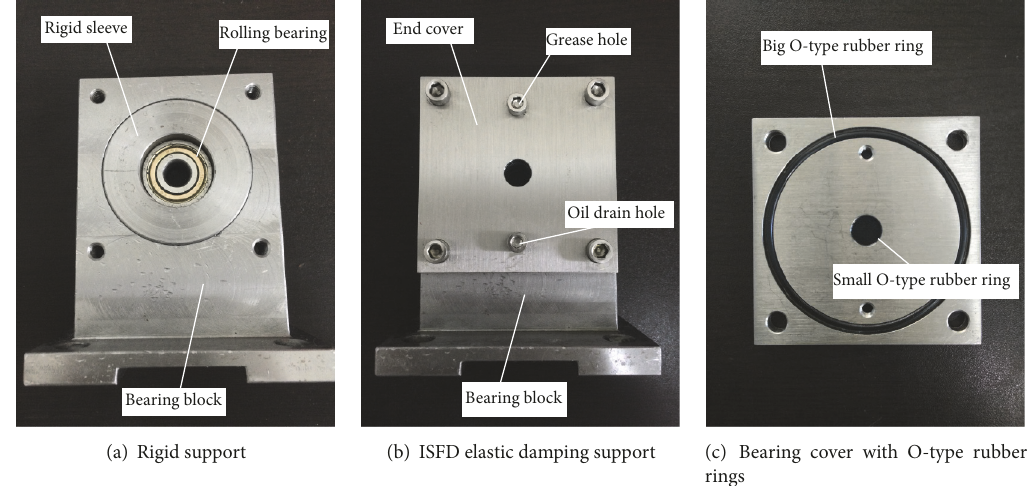
Figure 6: Two kinds of experimental support and bearing cover used in the elastic damping support.